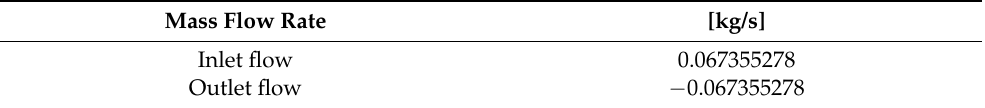
Table 3. Mass flow rate from axial water jacket.